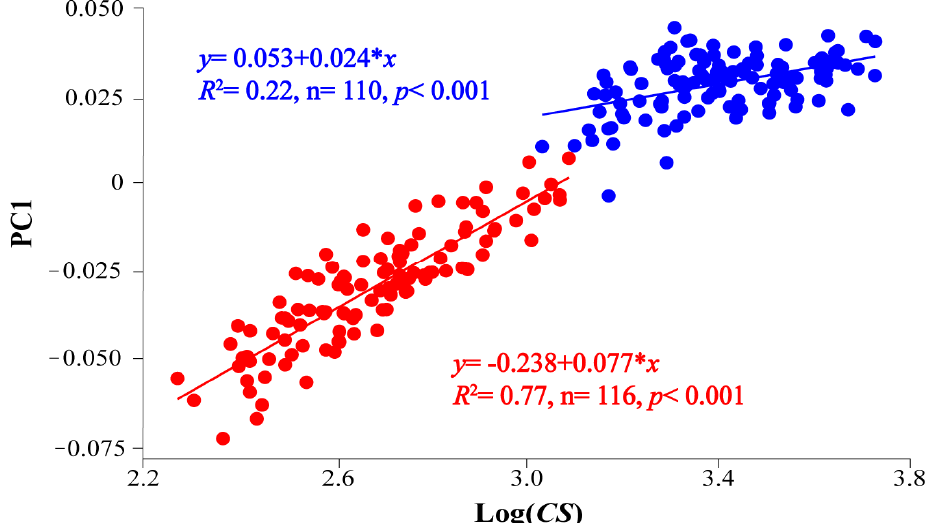
Figure 3. Linear regression between PC1 and log-centroid size (log- CS ) during larval and juvenile stages of Chelon auratus . Red dots are larvae (24 dph), blue dots are juveniles (54 dph).